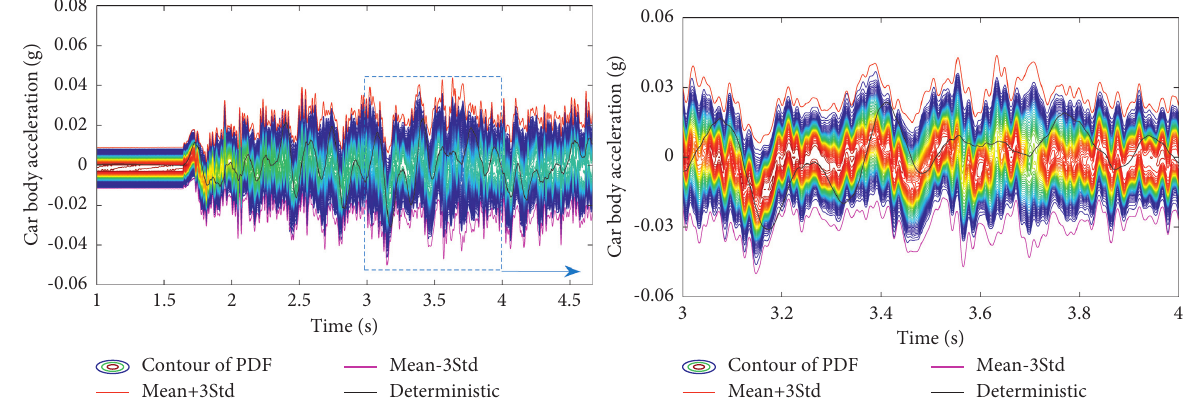
Figure 11: Contour of PDF of car body acceleration for ( v ) �